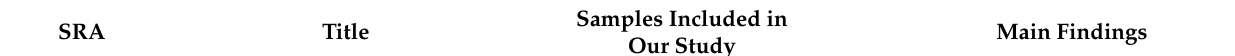
Table 1. Detailed information regarding the three selected studies matching our study